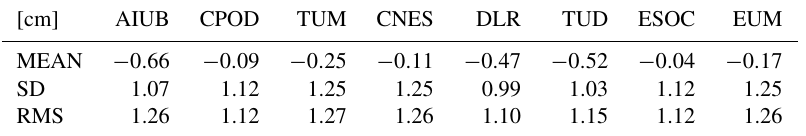
Table 7. SLR validation of combined orbit solutions by using variance component estimation with previous Helmert transformation. [cm]